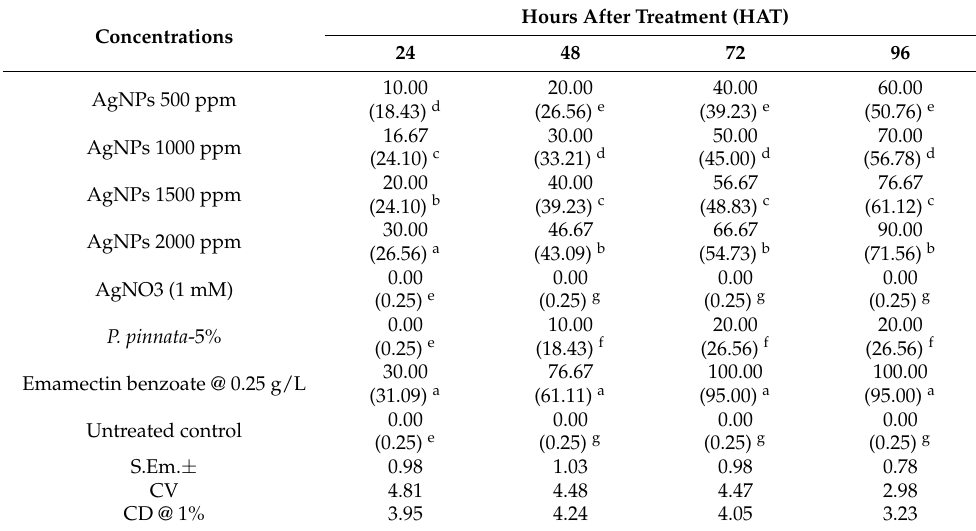
Table 2. Toxicity of green AgNPs synthesized from leaves of Pongamia pinnata on larval mortality of H. armigera (Instar